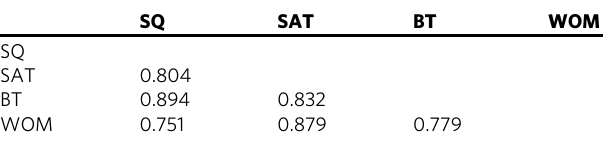
Table 4 HTMT analysis of the current study.